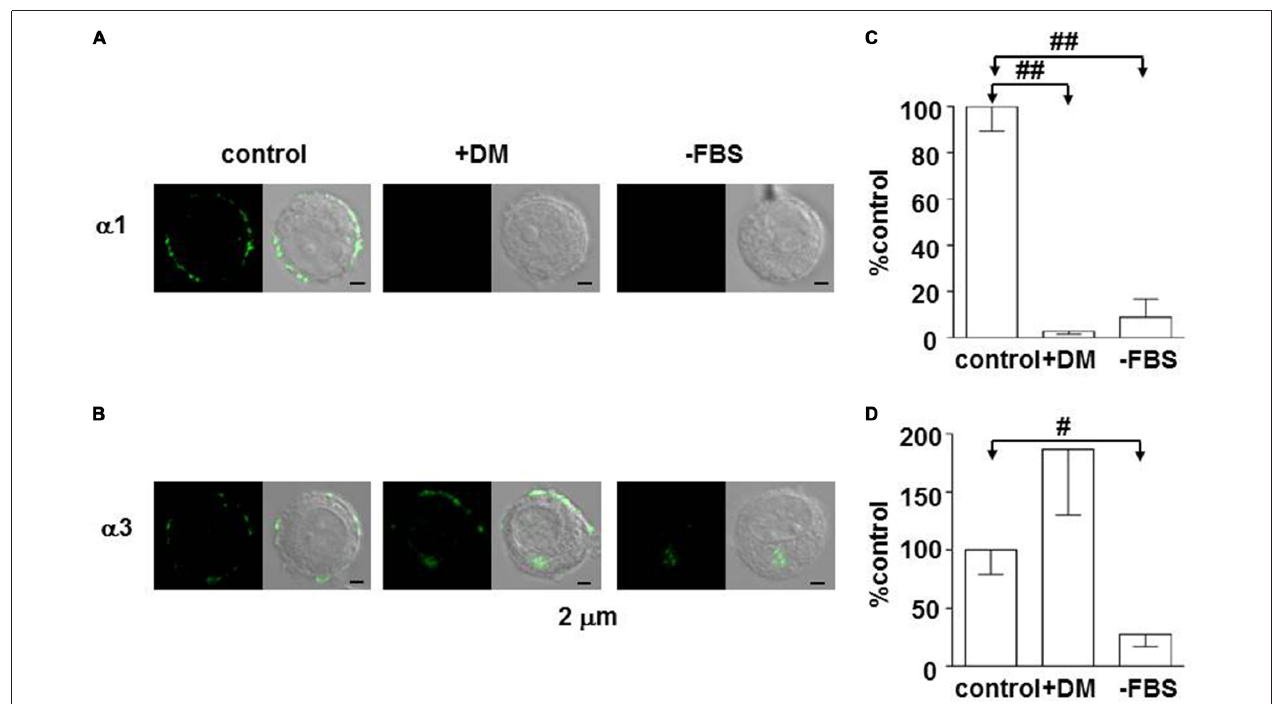
FIGURE 2 | Enhancement of expression of the GABA A α 3 subunit in PC12 cells by dexamethasone. (A,B) Immunofluorescent staining for α 1 and α 3 subunits in PC12 cells, respectively. Cells were cultured for 1 week in Dulbecco’s modified medium supplemented with 10% fetal bovine serum (FBS; control), Dulbecco’s modified medium with 10 µ M dexamethasone (+DM), or Dulbecco’s modified medium ( − FBS). Left and right images represent confocal fluorescent images and merge of fluorescent and DIC images. (C,D) Summaries of α 1- and α 3-like immunoreactivities, respectively. The amounts of α 1- and α 3-like immunoreactivities were measured by using ImageJ software (NIH, Bethesda, MD, USA). The amounts of the immunoreactivities in PC12 cells cultured with DM (+DM) and without DM and FBS ( − FBS) were expressed as percentages of those in the control PC12 cells, which were measured under the same conditions. The data indicate mean ± SEM ( C , n = 12, 12, and 10 for control, +DM, and − FBS, respectively; D , n = 19, 9, and 10 for control, +DM, and − FBS, respectively). # and ## represent statistical significance of P < 0.01 and P < 0.001, respectively. (B,D) Are reproduced from Inoue et al.